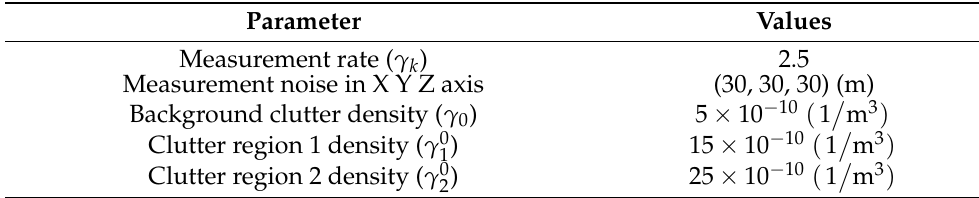
Table 2. Simulation parameters.